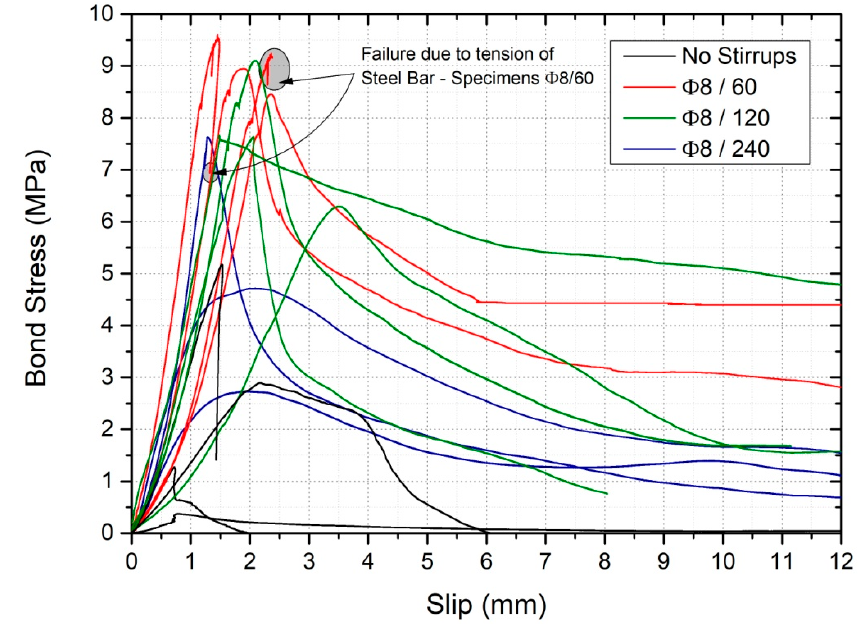
Figure 11. Bond stress–slip curves obtained from pull-out tests.